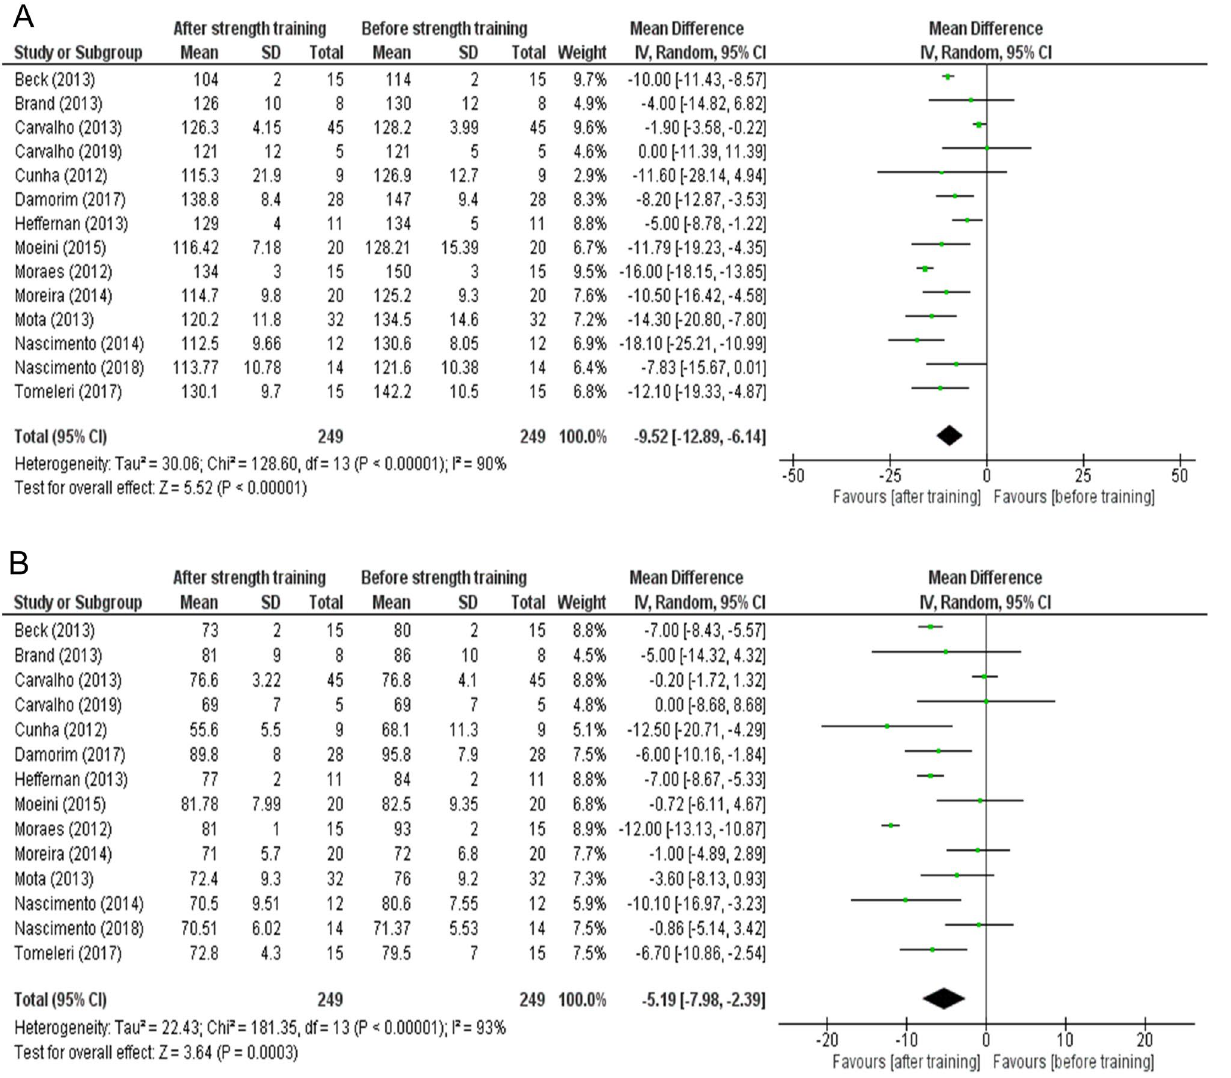
Figure 2. ( A ) Effects of strength training on systolic blood pressure in overall hypertensive individuals. ( B ) Effects of strength training on diastolic blood pressure in general hypertensive